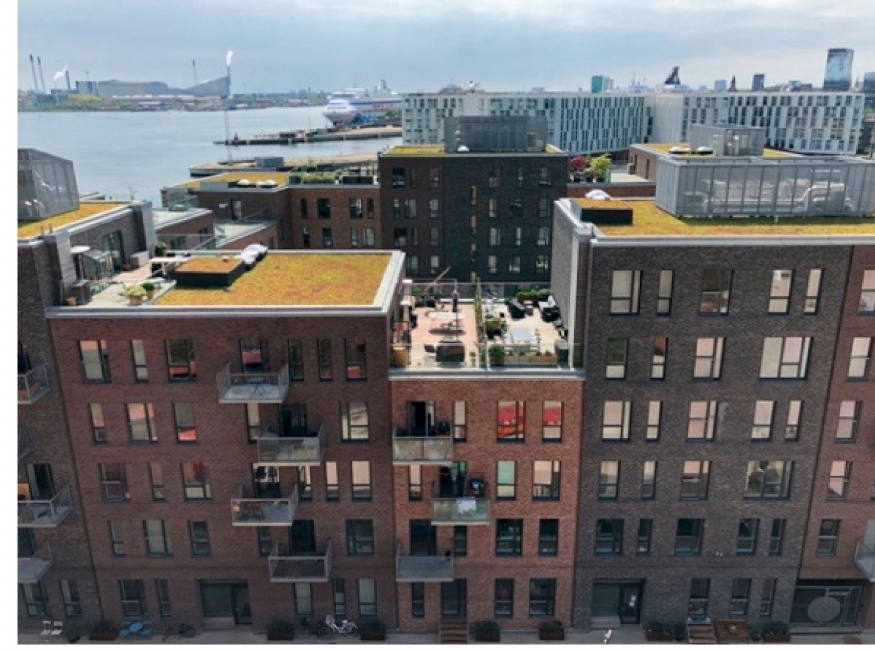
Figure 12. Photograph of case study 3: Harbour Park. Source: